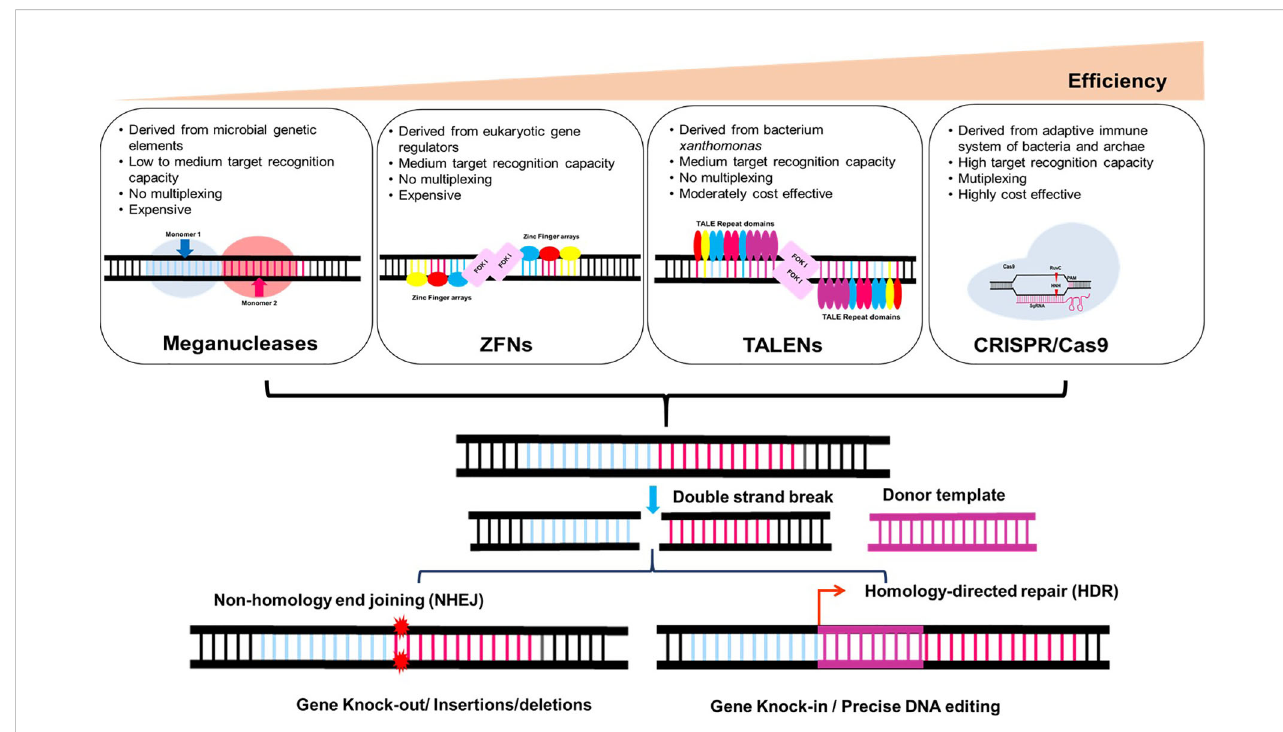
FIGURE 1 Plant genome editing in a targeted manner: Induction of double-stranded break ’ s (DSB) in DNA at a speci fi c locus by engineered nucleases such as Meganucleases, ZFNs (Zinc fi nger nucleases), TALENs (Transcription activator-like effector nucleases) and CRISPR-Cas9 (CRISPR-Cas-mediated RNA- guided DNA endonucleases). Endogenous DNA repair mechanisms repair DSBs by non-homologous end joining or homology-guided